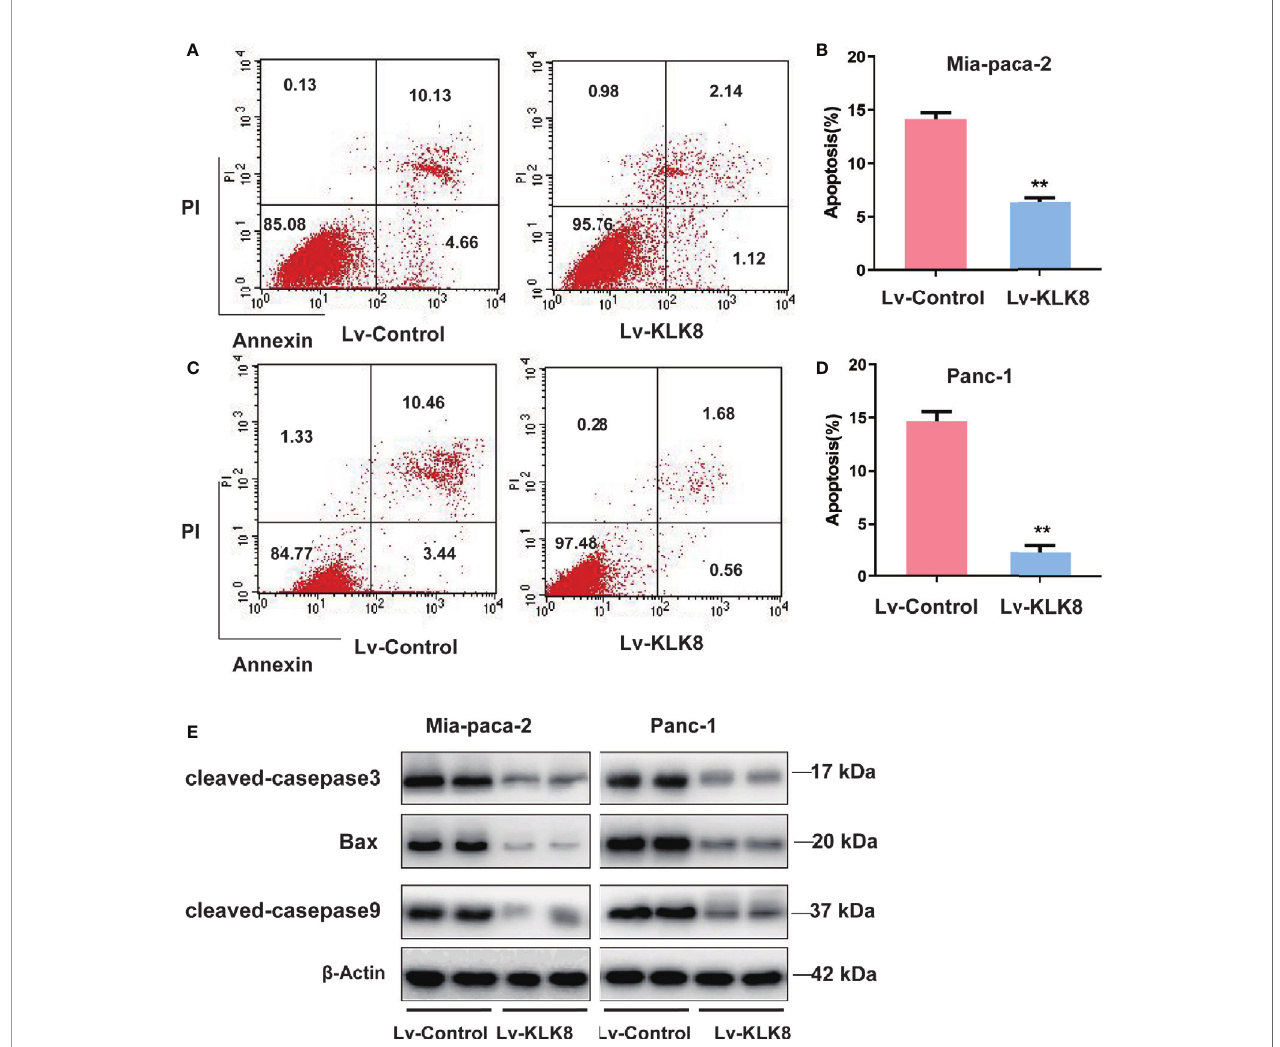
FIGURE 4 | KLK8 overexpression inhibited apoptosis of PDAC cells. KLK8 overexpression was induced with recombinant Lentivirus infection (Lv-KLK8) in human pancreatic cancer cell lines Mia-paca-2 (A, B) and Panc-1 (C, D) , and an empty adenovirus served as control (Lv-Control). Cell apoptosis was determined by Annexin V-FITC and PI double staining analysis performed by fl ow cytometry. Representative fl ow cytometry images were shown (A, C) . (B, D) demonstrated the quanti fi ed data of cell apoptosis. (E) pro-apoptotic markers cleaved caspase-3, cleaved caspase-9 and Bax assessed by western blot. Data are expressed as the mean ± SEM (n=3). **p < 0.01 vs